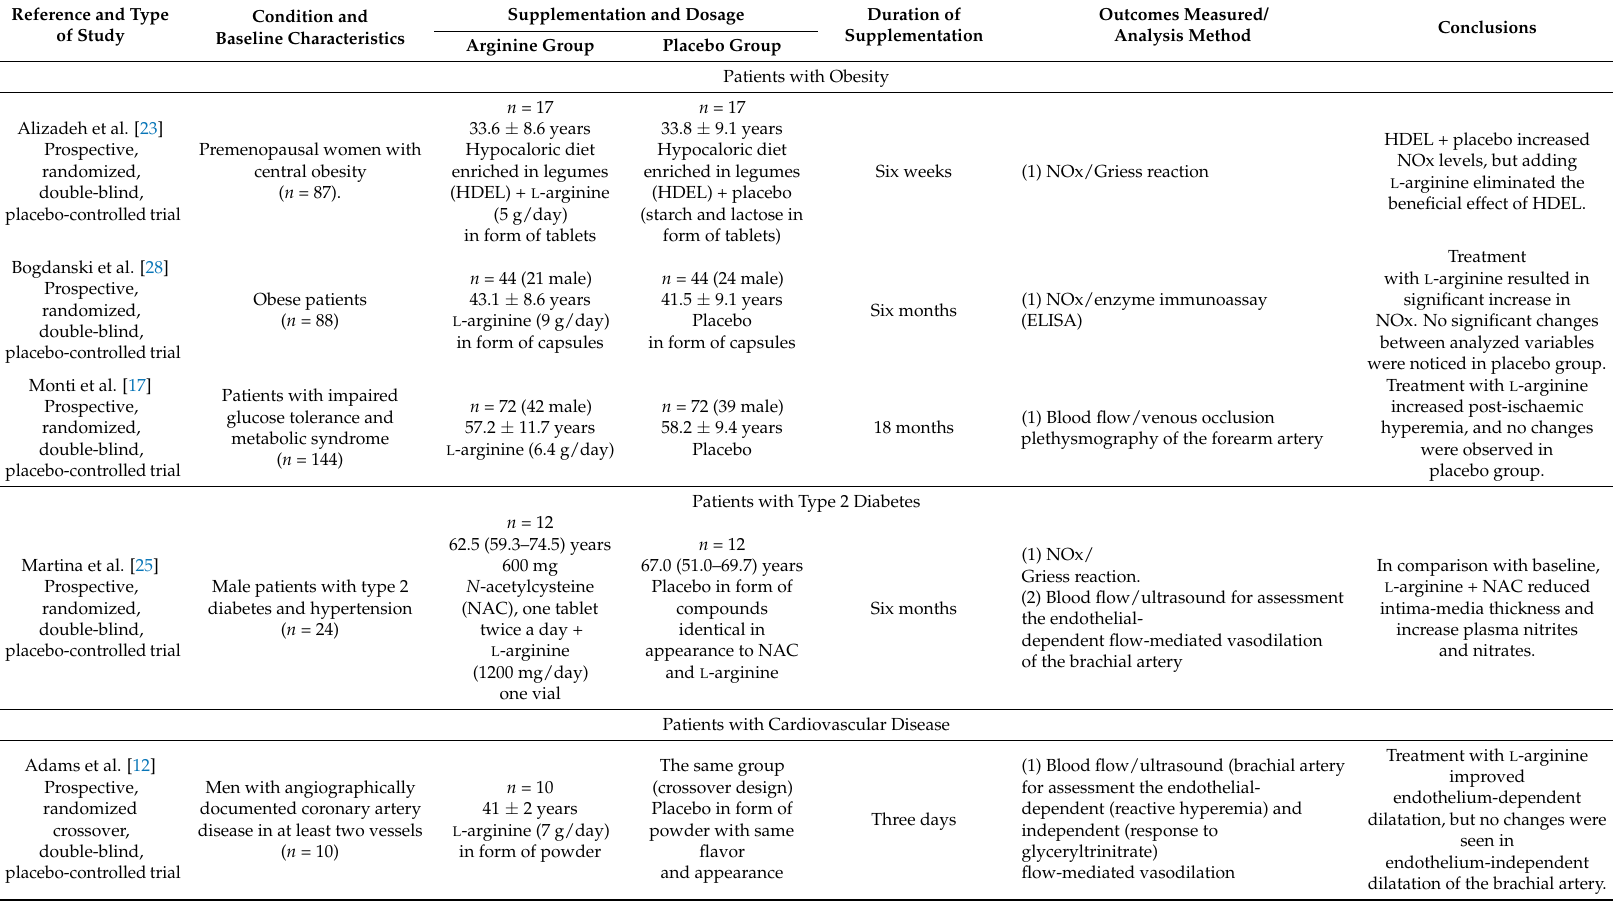
Table 1. Characteristics of studies verifying the effects of oral supplementation of L -arginine compared to placebo treatments on blood flow, nitrate/nitrite (NOx), and asymmetric dimethylarginine (ADMA) responses in patients with obesity, type 2 diabetes mellitus, and cardiovascular